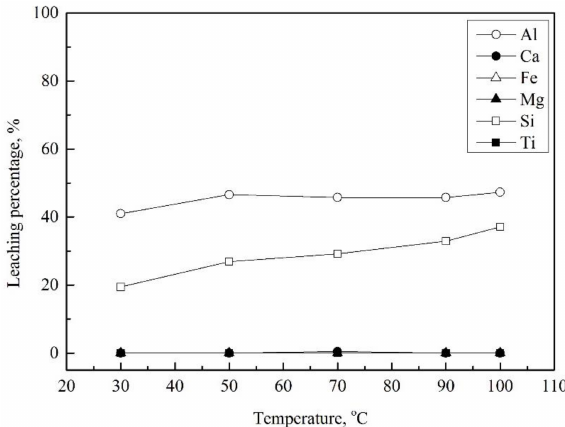
Figure 7. The effect of reaction temperature on the leaching of the oxides from the mechanically activated dross in a 5 M NaOH solution. (reaction time: 2 h, stirring speed: 200 rpm, pulp density: 20